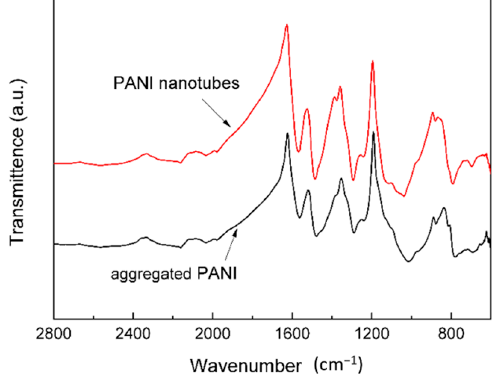
Figure 3. FT − IR spectra of PANI nanotubes and aggregated PANI.